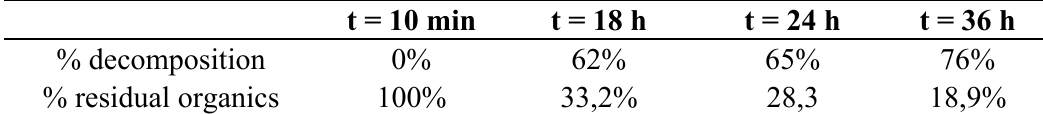
as a function of time at 20